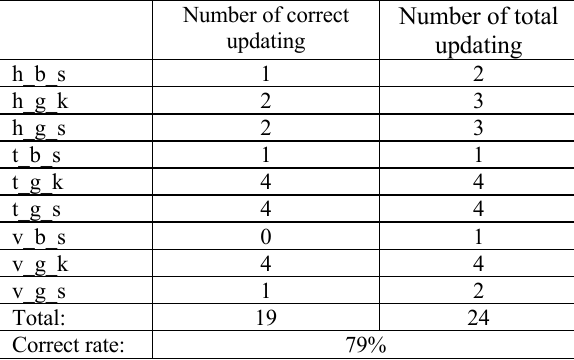
Table 6. Statistics of radio map updating